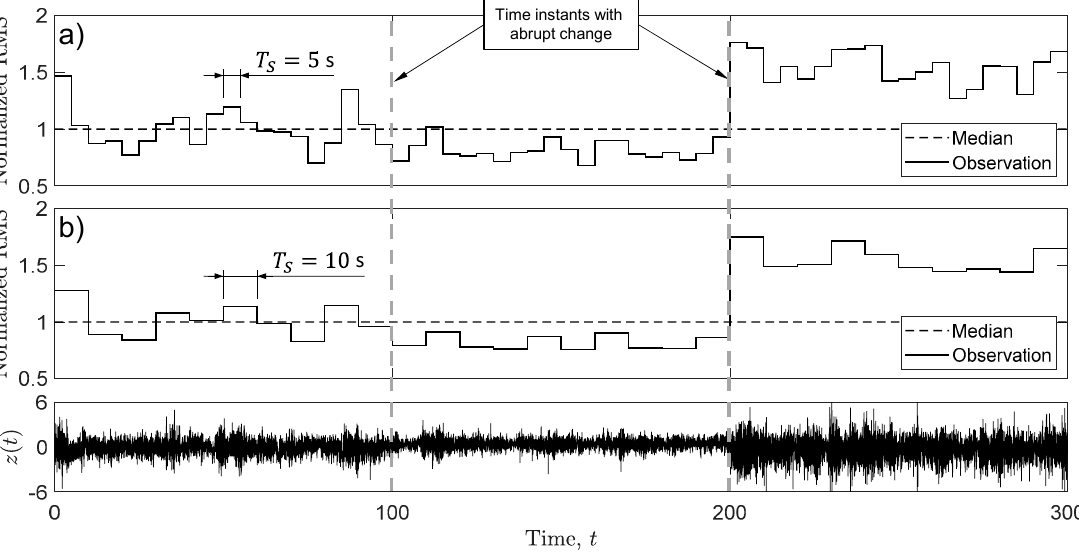
Figure 10. Run test applied to a measured stress-time history classified as non-stationary: ( a ) 𝑇 (cid:3046) = 5 s and ( b ) 𝑇 (cid:3046) = 10 s .